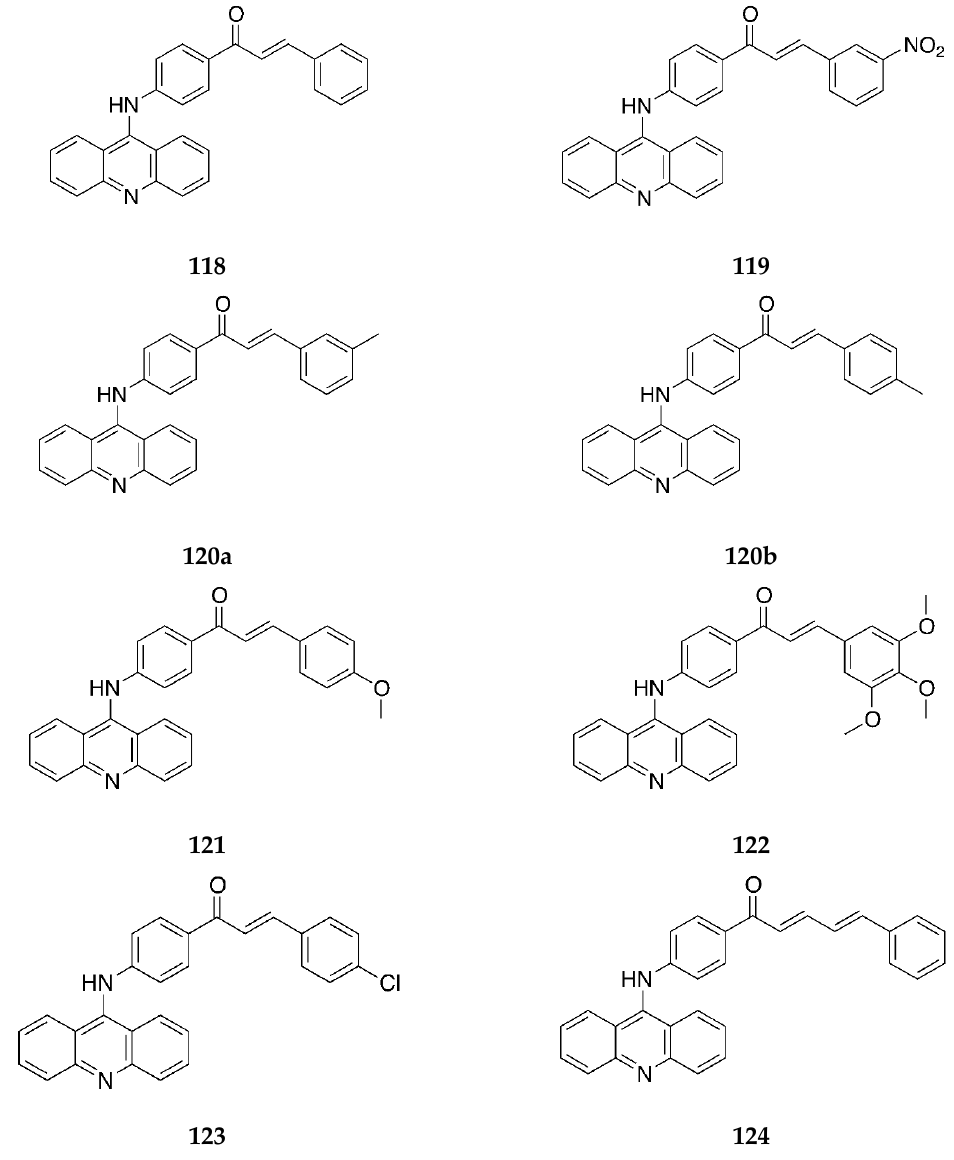
Figure 48. Chemical structures of 4-aminochalcones derivative chalcones with an acridinyl group.